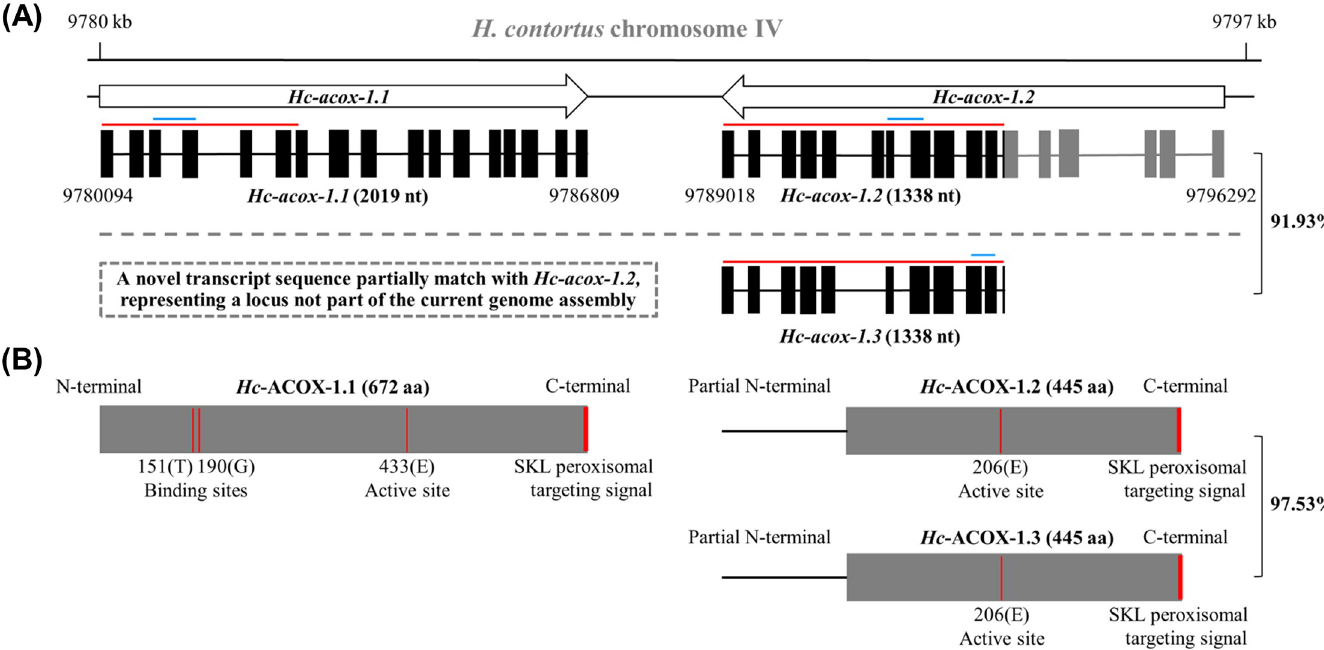
Fig 1. Complementary DNA-confirmed gene models of acox-1 in Haemonchus contortus . (A) Gene structures of Hc - acox-1 . 1 and Hc-acox-1 . 2 are defined in H . contortus based on complementary DNA sequences. Arrow boxes indicate two adjacent gene loci of Hc-acox-1 , with a 91.93% identity indicated between Hc-acox-1 . 2 and Hc-acox-1 . 3 , a possible locus not part of the current genome, based on NCBI blastn searching. Black blocks represent exons that were matched with cloned sequences, and horizontal lines represent introns indicated by transcripts. The numbers above and below the boxes indicate the start and end of gene loci. The lines above exons represent the sequences targeted in RNAi (red) and in qPCR (blue), respectively. (B) Predicted key sites in the deduced amino acid sequences of H c-ACOX- 1.1, -1.2 and -1.3, with a 97.53% similarity indicated between the latter two proteins based on NCBI blastp searching. Predicted flavin adenine dinucleotide binding sites 151 (T, threonine) and 190 (G, glycine), and active site 206/433 (E, glutamic acid) of deduced Hc -ACOX-1 are indicated. The amino acid sequences without SKL are used for polyclonal antibodies preparation. SKL represents peroxisomal targeting signal type 1 (PTS1). S: serine, K: lysine, L: leucine.